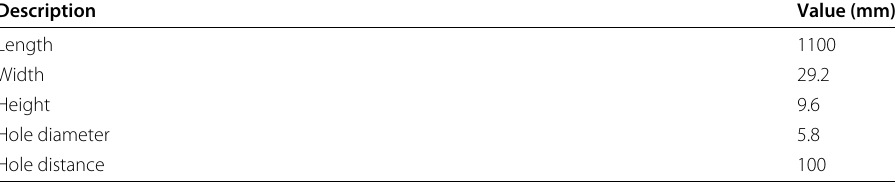
Table 2 Technical data for sample beam